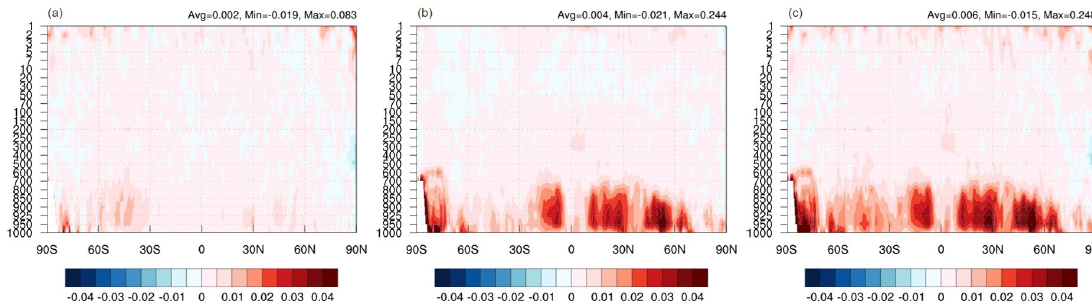
Figure 2. The zonal mean ES for temperature from ( a ) the SPDT, ( b ) the SPPT, and ( c ) the stochastic perturbation hybrid tendencies (SPHT) scheme (i.e., SPDT + SPPT). Results are shown for the first cycle background fields at 12:00 UTC on 22 June 2018.